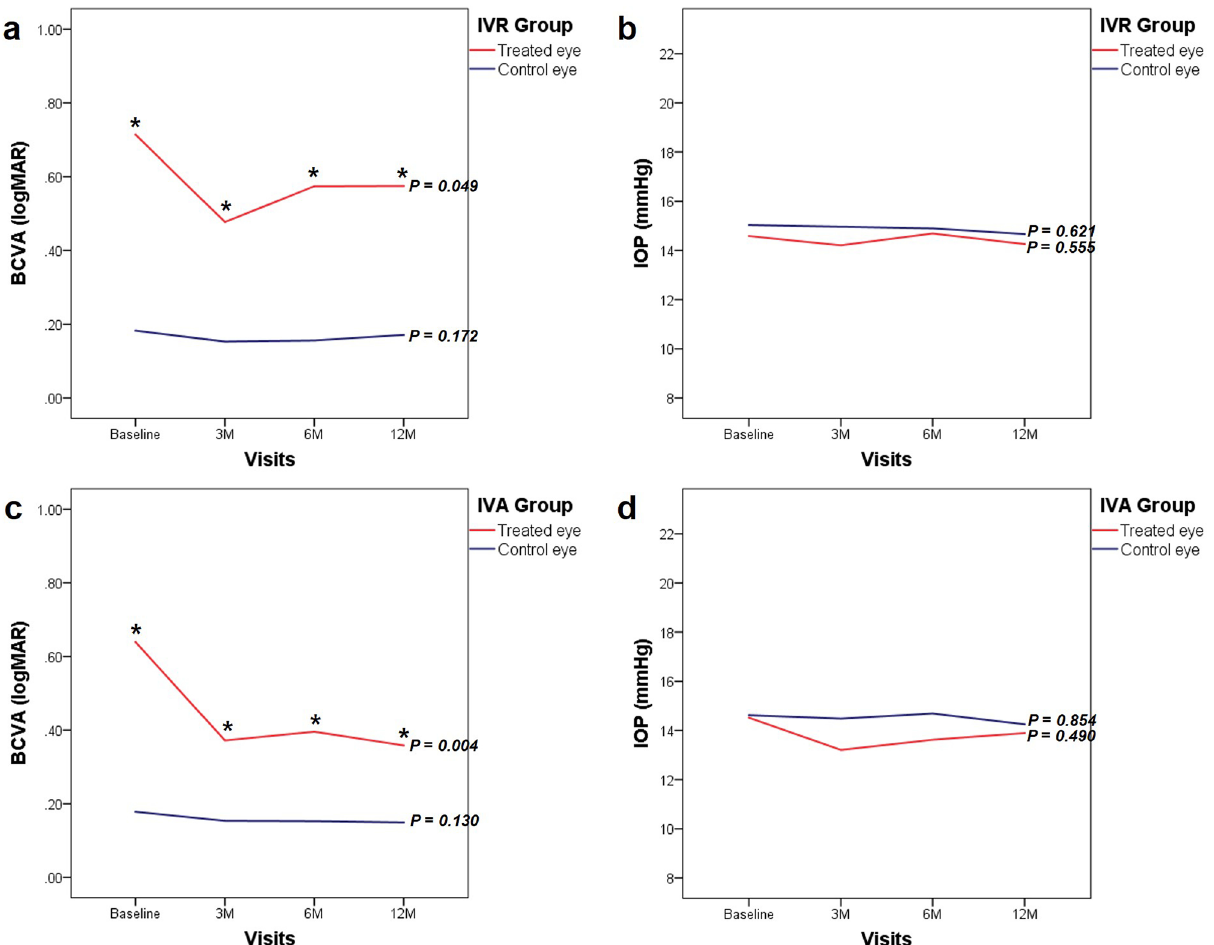
Figure 1. Changes in the best corrected visual acuity (BCVA) and intraocular pressure (IOP). ( a ) BCVA in the group administered intravitreal ranibizumab (IVR) injection. ( b ) IOP in the group administered IVR injection. ( c ) BCVA in the group administered intravitreal aflibercept (IVA) injection. ( d ) IOP in the group administered IVA injection. p Values (Wilcoxon signed-rank test) are shown for the differences between the baseline values and values at 12 months. Statistically significant differences ( p < 0.05) between the values for the treated and control eyes are represented with asterisks (Mann–Whitney U